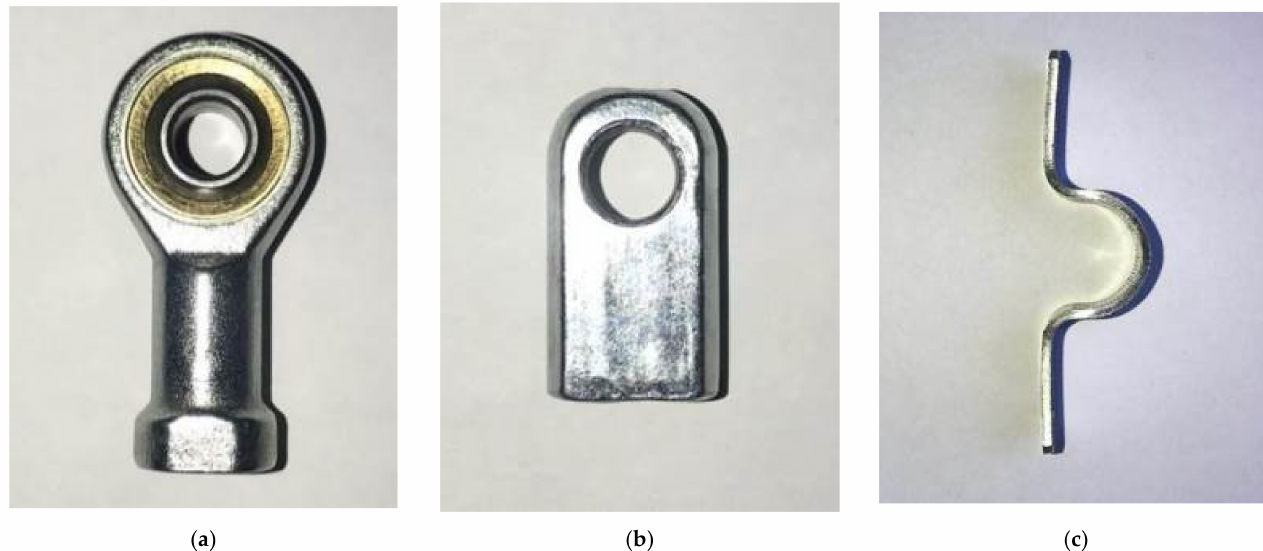
Figure 10. Fisheye joint with ( a ) round and flat joint with ( b ) and casing clamp with ( c